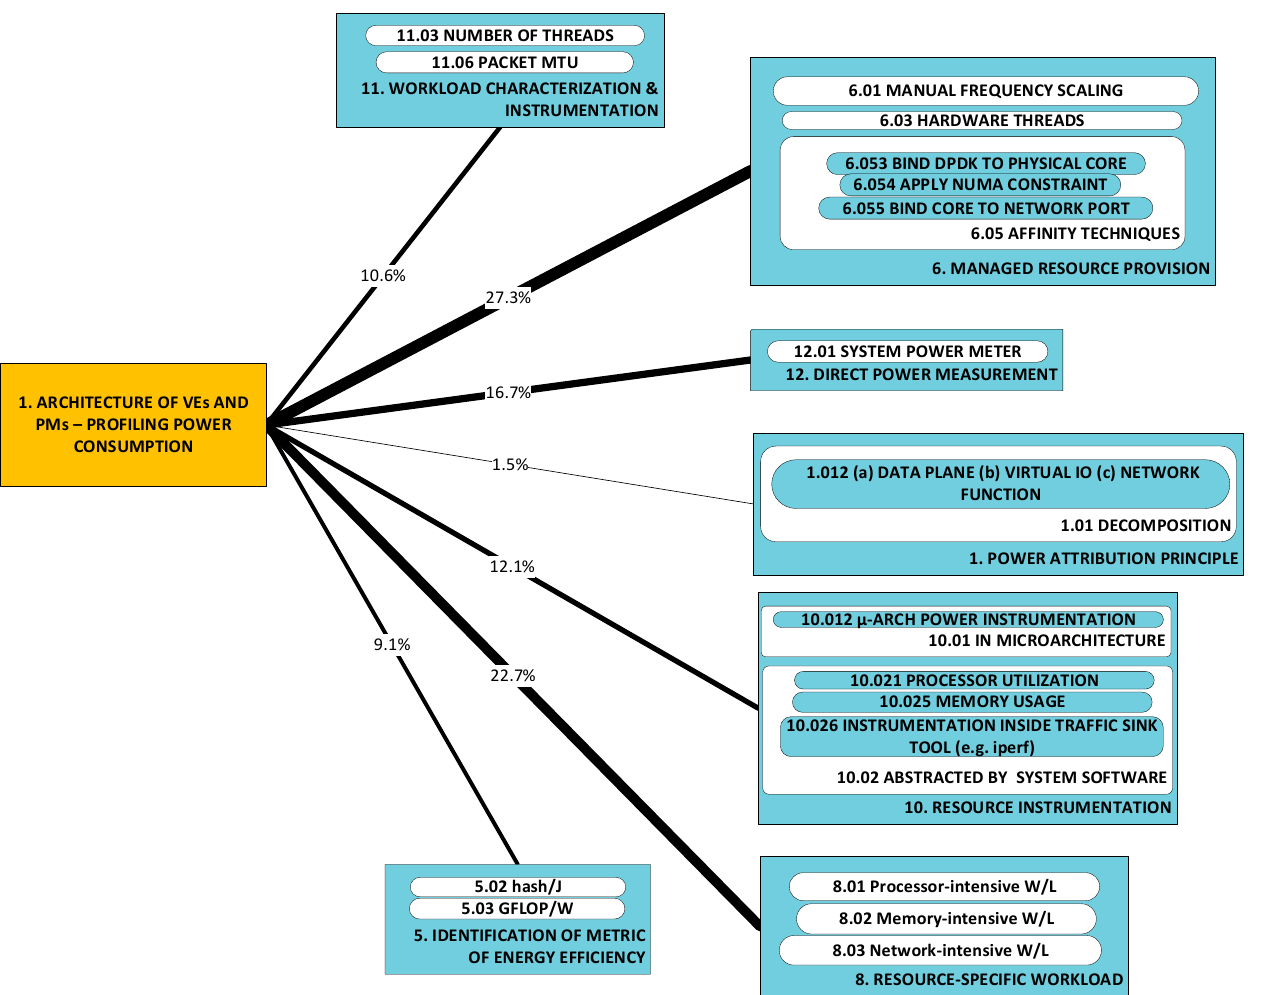
Figure 7. Approaches to solving challenges in category P1; utility metric U (cid:2885) thickness and as a percentage. RUs in the respective categories are the following: P1: [48–51]; A1: [48];